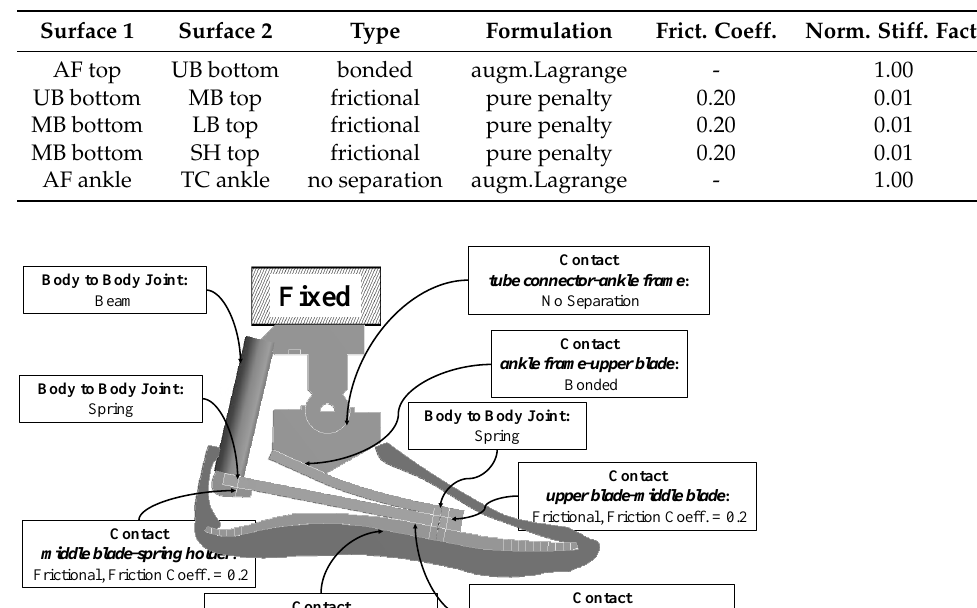
Table 4. Contacts’ properties. See also Figure 7. AF = ankle frame; UB = upper blade; MB = middle blade; LB = lower blade; SH = spring holder; TC = tube connector.